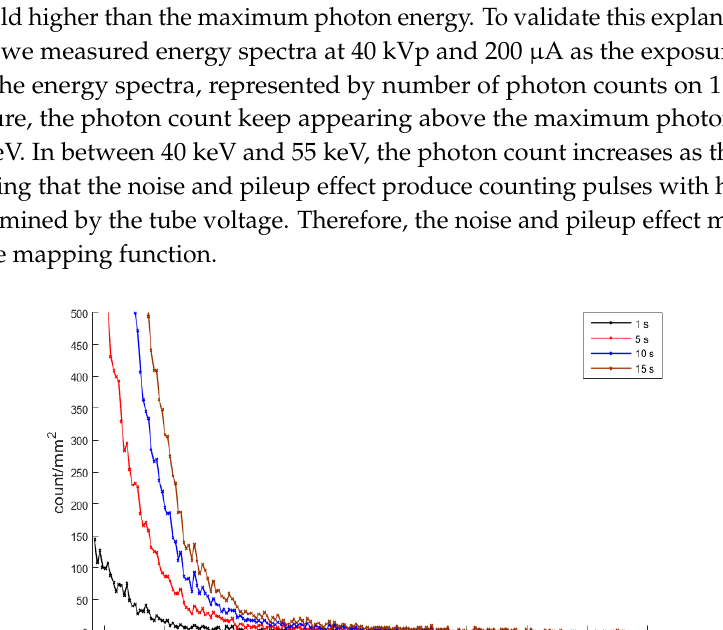
Figure 10. The energy spectra at 40 kVp and 200 μ A. The photon counts on 1 mm 2 are appearing above 40 keV because of the noise and pileup effect.